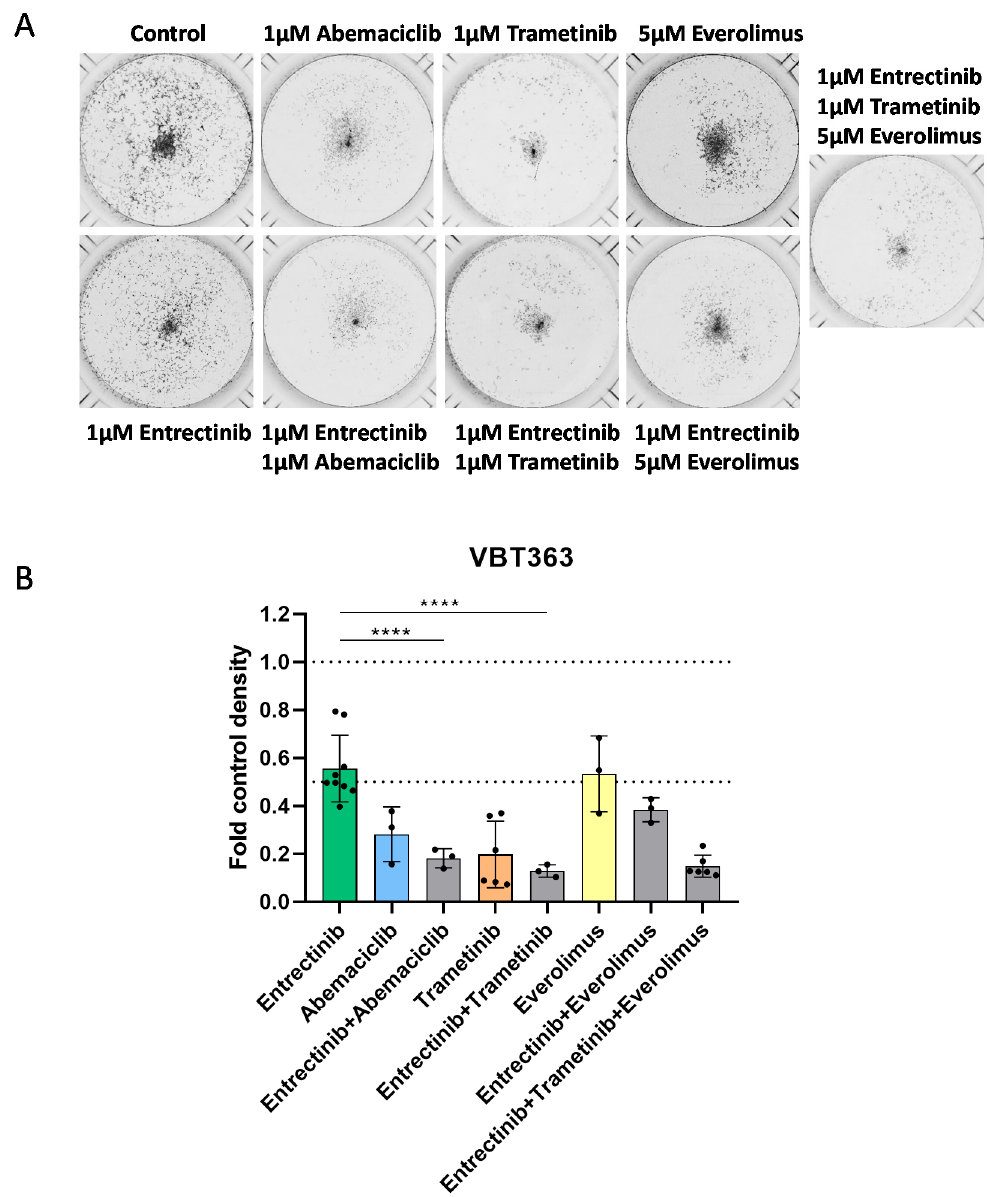
Figure 6. E ff ect of entrectinib and combination treatment on cell viability and toxicity. E ff ects of combined long-term application of entrectinib with trametinib, abemaciclib and / or everolimus in Figure 6. Effect of entrectinib and combination treatment on cell viability and toxicity . Effects of VBT363 cells were tested by clonogenicity assays in triplicates. ( A ) Cells were fixed and stained with combined long-term application of entrectinib with trametinib, abemaciclib and/or everolimus in crystal violet, and wells were photographed. ( B ) Densitometric quantification of photomicrographs shown in ( A ) using ImageJ2 software was assessed. Statistical significance of di ff erences was analyzed by one-way ANOVA, ****, p <